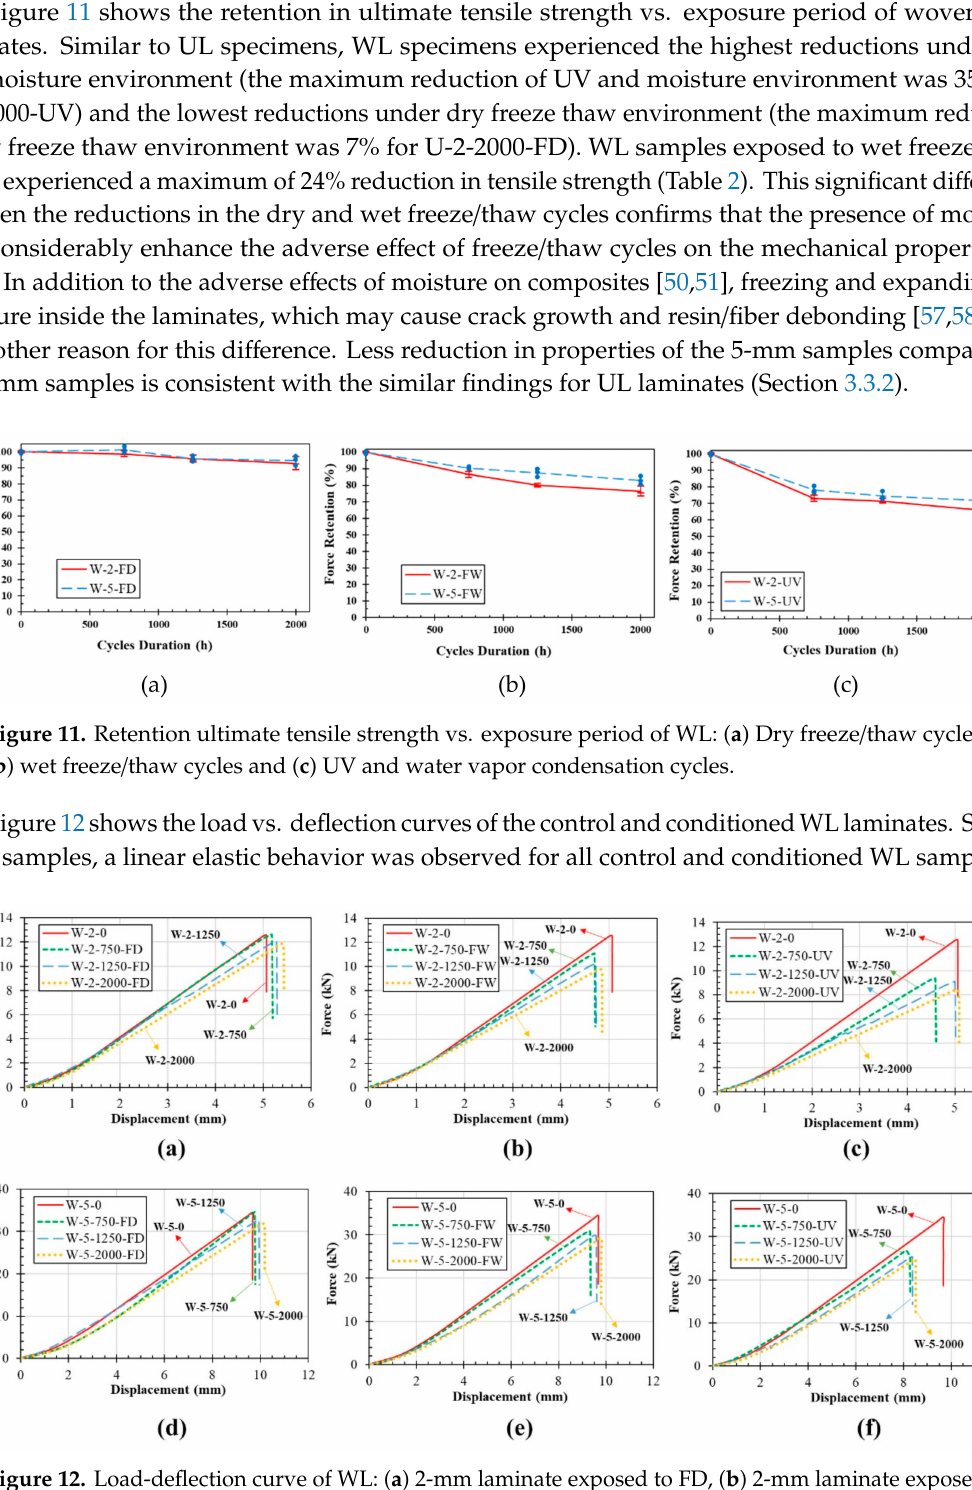
Figure 12. Load-deflection curve of WL: ( a ) 2-mm laminate exposed to FD, ( b ) 2-mm laminate exposed to FW, ( c ) 2-mm laminate exposed to UV, ( d ) 5-mm laminate exposed to FD, ( e ) 5-mm laminate exposed to FW and ( f ) 5-mm laminate exposed to